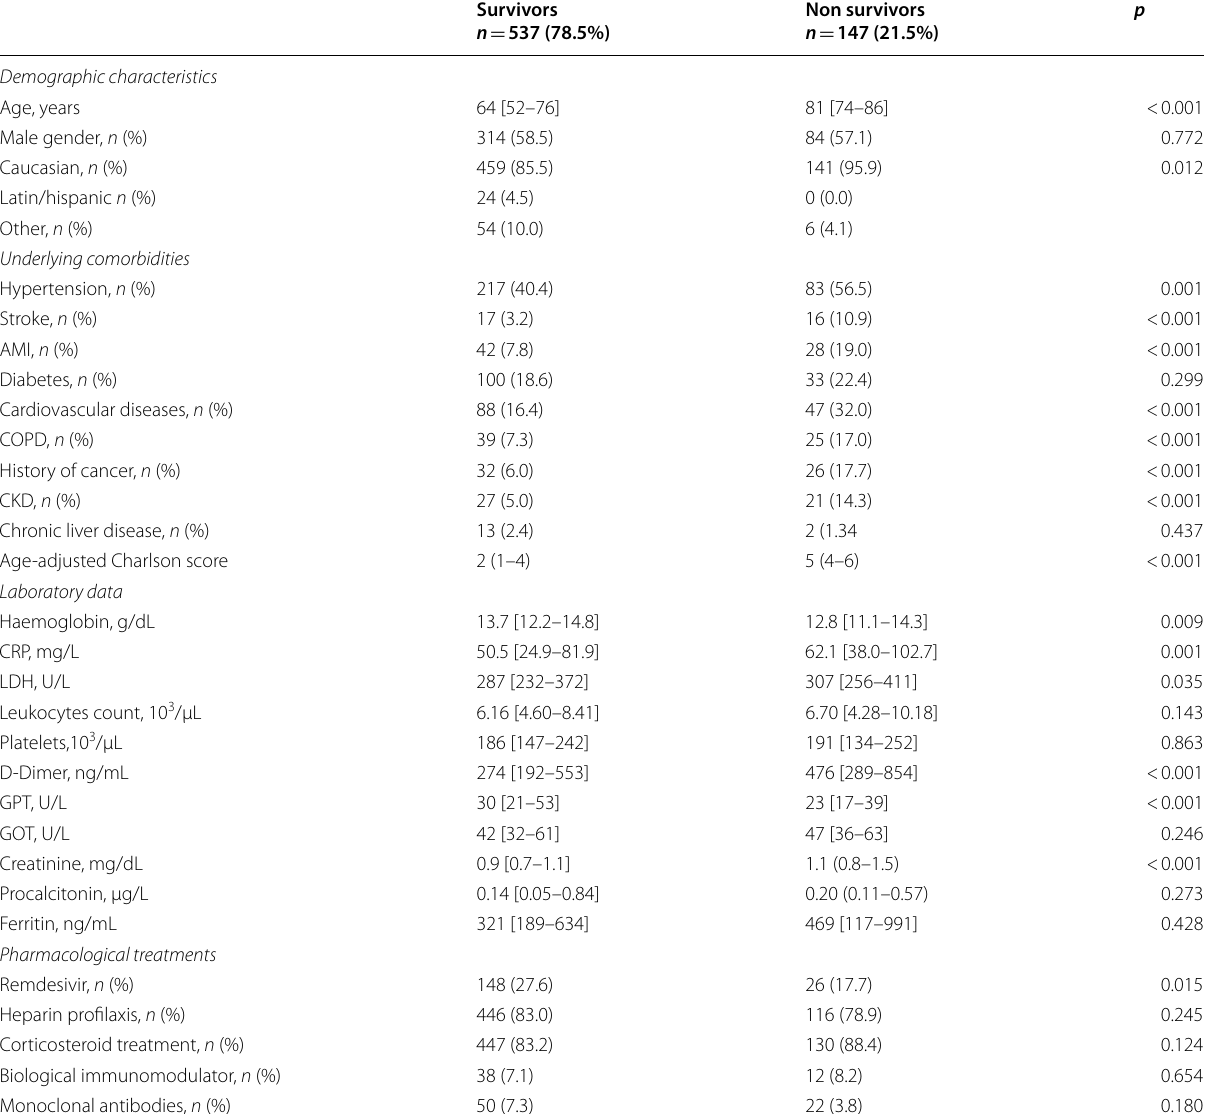
Table 3 Clinical characteristics at hospital admission of survivors and non survivors patients